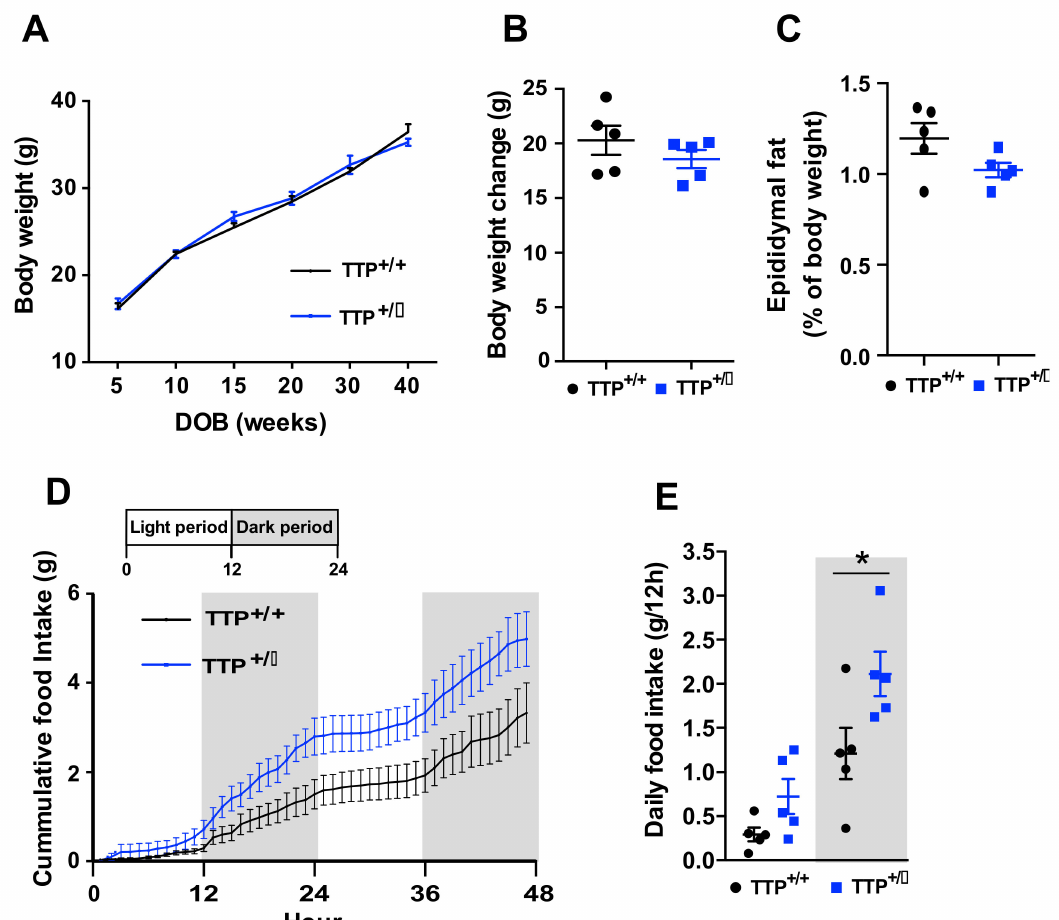
Figure 8. Deficiency of TTP results in an increase in food intake and no alteration of body weight. Body weight changes were measured in both the TTP-deficient mice and wild-type mice under standard diet treatment. ( A ) No significant difference in body weight and ( C ) adiposity (ratio of epididymal fat weight per body weight) was found between TTP-deficient mice and wild type mice during the observation periods (from 5-week-old to 40-week-old). ( B ) Cumulative body weight gain for 36 weeks was not significantly altered between the TTP-deficient mice and wild-type mice. ( D ) Cumulative food intake for 48 h tended to be higher in the TTP-deficient mice (10-week-old) than in wild-type mice. ( E ) Average food intake for 12 h was enhanced in the TTP-deficient mice compared to that in wild-type mice. Data are presented as the mean ± SEM. n = 5 mice per group. * p < 0.05. SEM; standard error of the